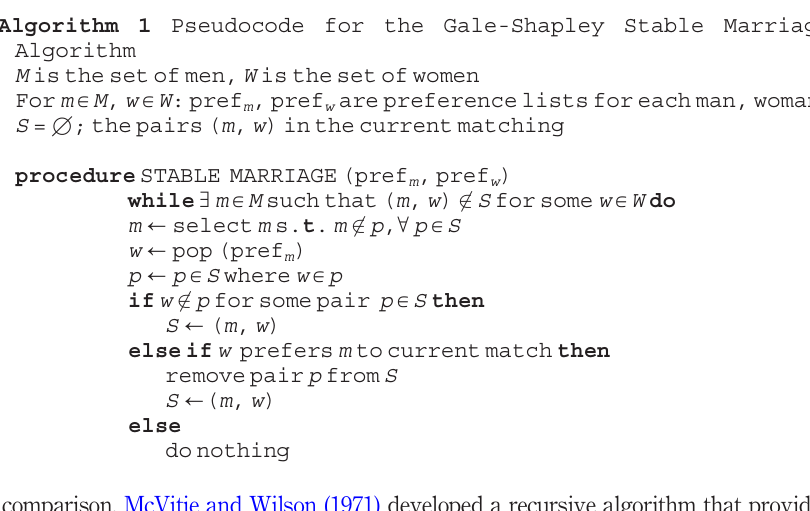
Algorithm 1 Pseudocode for the Gale-Shapley Stable Marriage Algorithm M is the set of men, W is the set of